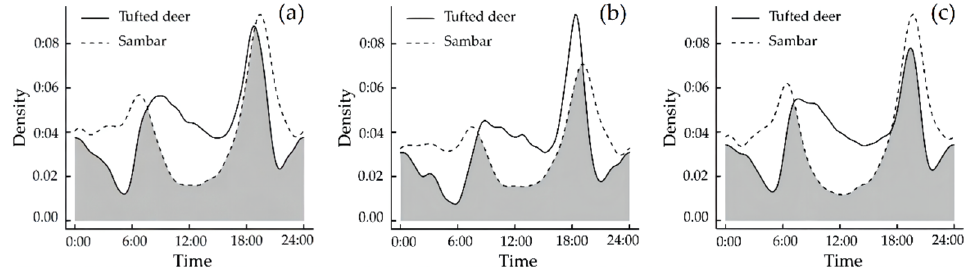
Figure 5. The daily activity patterns of tufted deer and sambar in the annual time scale ( a ), dry season time scale ( b ), and rainy season time scale ( c ). Overlaps are represented by the shaded gray area.